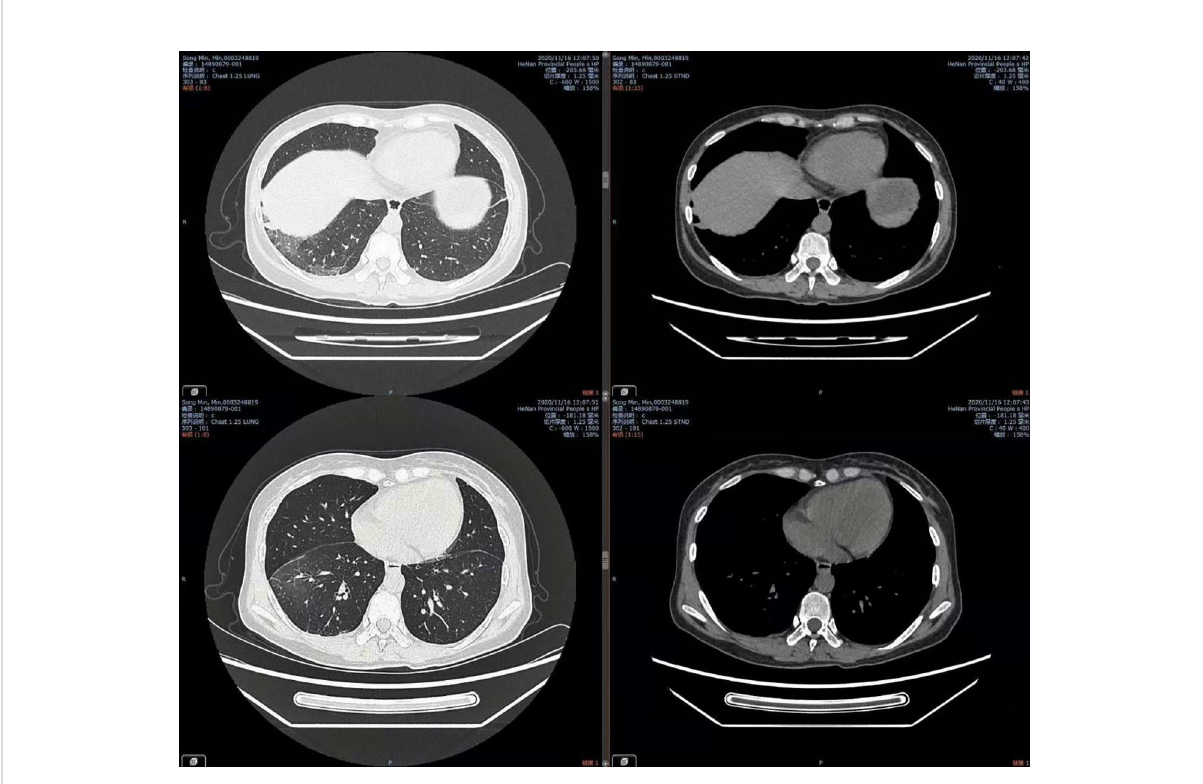
FIGURE 2 Chest CT on Aug 16, 2020, showing signi fi cant absorption of lesions in the left lower